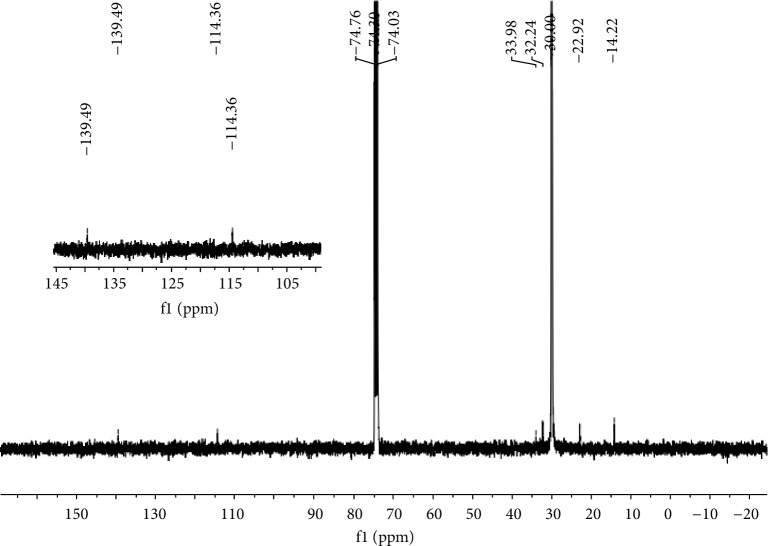

13C NMR spectrum of the polyethylene generated using Fe4/MAO at 60°C in C2D2Cl4 (run 9, Table 4).